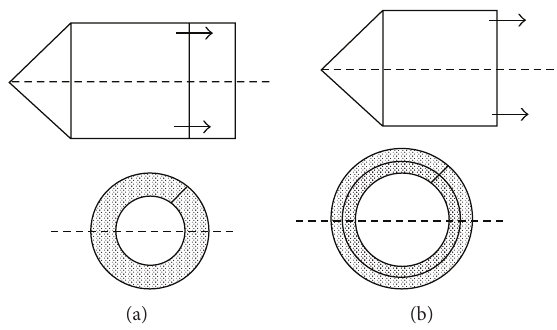
Figure 10: The schema of interchamber burning of a mixture in rotating DW ((a) bounded flow) and schema of “exterior” burning in a ring gas layer with the help of rotating DW ((b) unbounded flow, gaseous charge jet is created at axial or radial injection of a mixture).